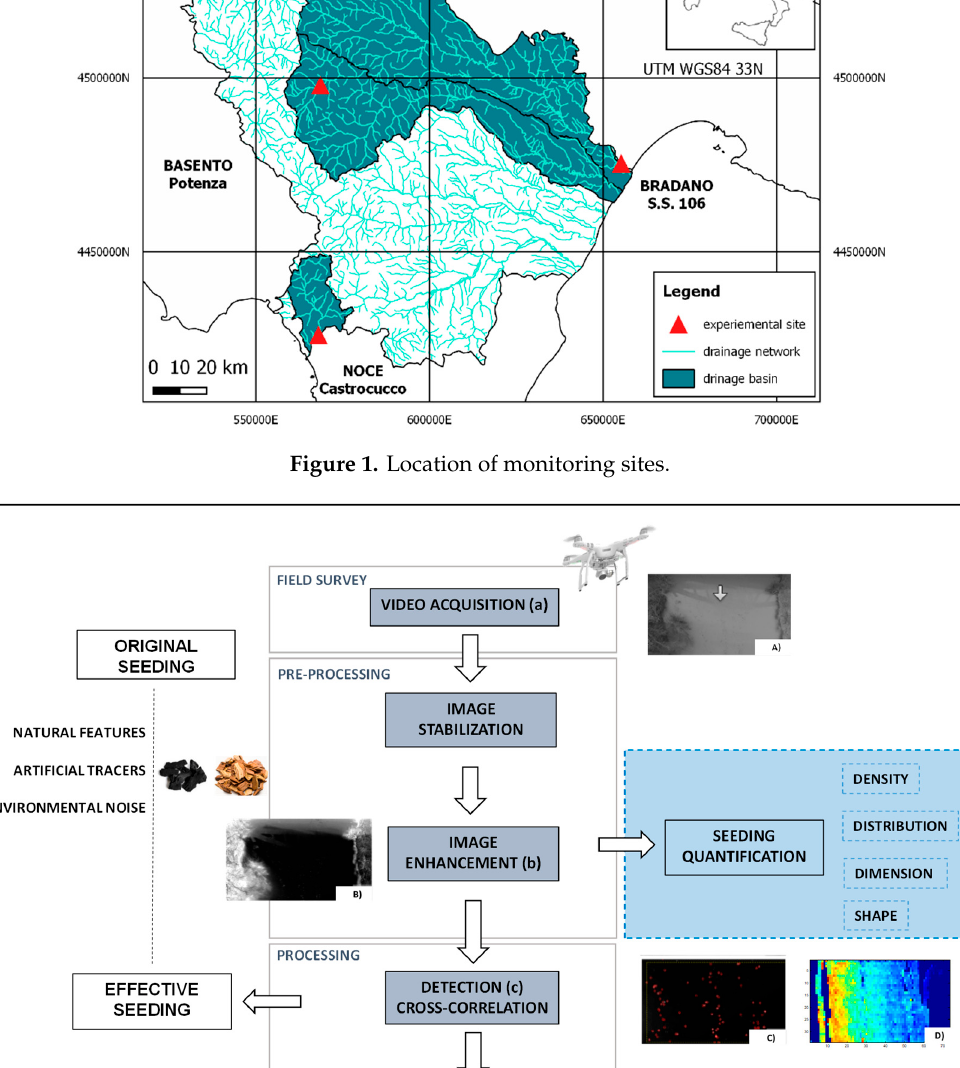
Table 1. Main river flow characteristics in three case studies.